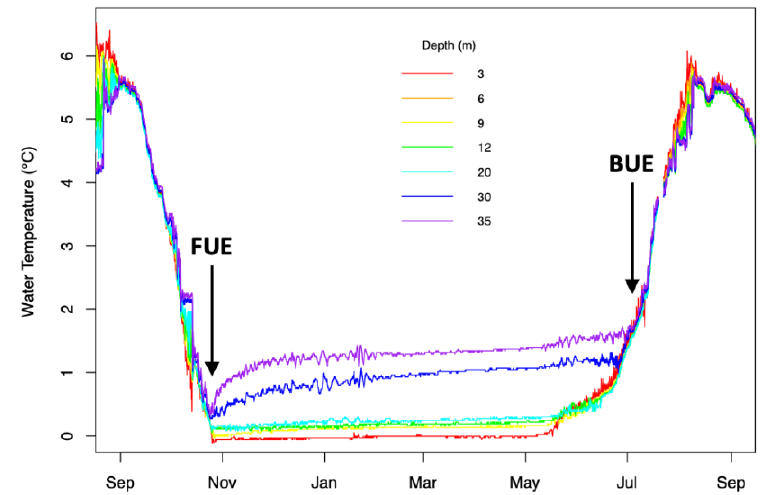
Figure 3. Example time series of lake water temperature measured at different depths from September 2009 to September 2010. During the summer period of open water (typically July–October/November), the lake is typically well-mixed, and the water temperature does not vary much with depth. However, once ice appears on the lake, it stratifies until the ice disappears, with colder temperatures near the surface and warmer temperatures near the bottom. The appearance (FUE) and disappearance (BUE) of ice is indicated with arrows.